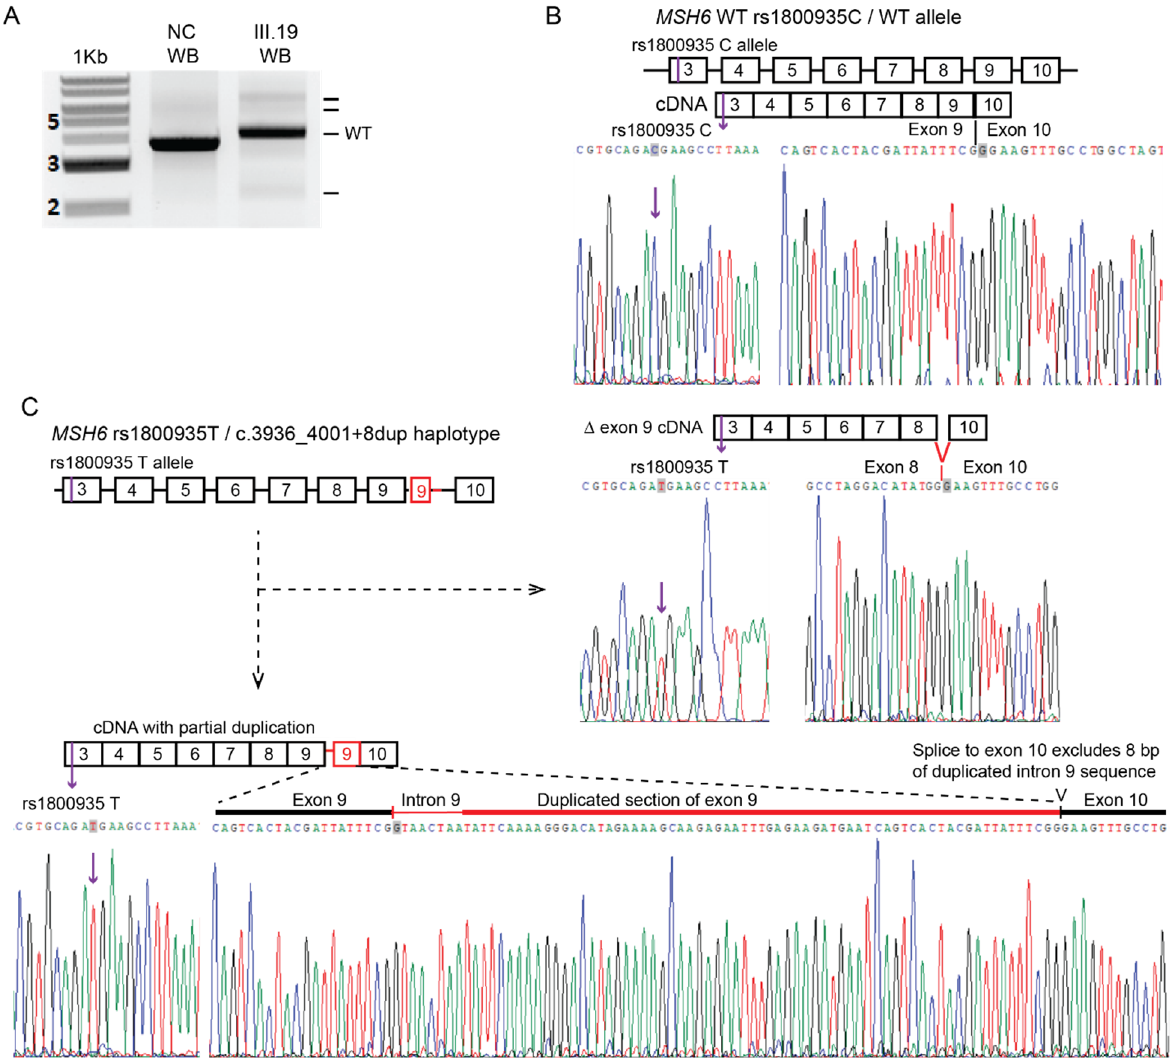
Figure 6. MSH6 c.3936_4001+8dup (intronic) variant is fully penetrant. ( A ) Electrophoresis gel showing MSH6 exon 3–10 cDNA fragments from whole blood (WB) RNA samples of a non-carrier control and III.19, dual carrier of the MSH2 and MSH6 variants, alongside the 1 Kb Ladder (New England Biolabs, Ipswich, MA, USA). Fragment sizes (kb) for the ladder are shown on the left. As indicated by black lines, the full-length wild-type (WT) fragment (predicted length 3.671 kb) was detected in both individuals, with additional shorter and longer cDNA fragments consistent with altered splicing observed in III.19, as marked by black lines on the right. ( B , C ) Illustrative examples of (partial) electropherograms from cloned individual transcripts of III.19 WB cDNAs shown in A, containing the expressed allele of the rs1800935C>T p.D180D (silent) SNP within exon 3, for which III.19 was heterozygous, and which was used to trace the allelic origin of expression of the normal transcripts and the erroneously spliced transcripts. ( B ) The C allele of rs1800935 was linked exclusively to normal transcripts with normal splicing from exon 9 to exon 10. ( C ) The T allele of rs1800935 was linked to the MSH6 c.3936_4001+8dup variant in genomic DNA. In cDNA, all erroneously spliced transcripts, including the exon 9-skipped transcript (right) and the partially duplicated transcript (below), were both linked to the rs1800935 T allele. No normal transcripts were observed with the rs1800935 T allele, indicating the c.3936_4001+8dup variant allele of MSH6 does not produce normal transcripts.